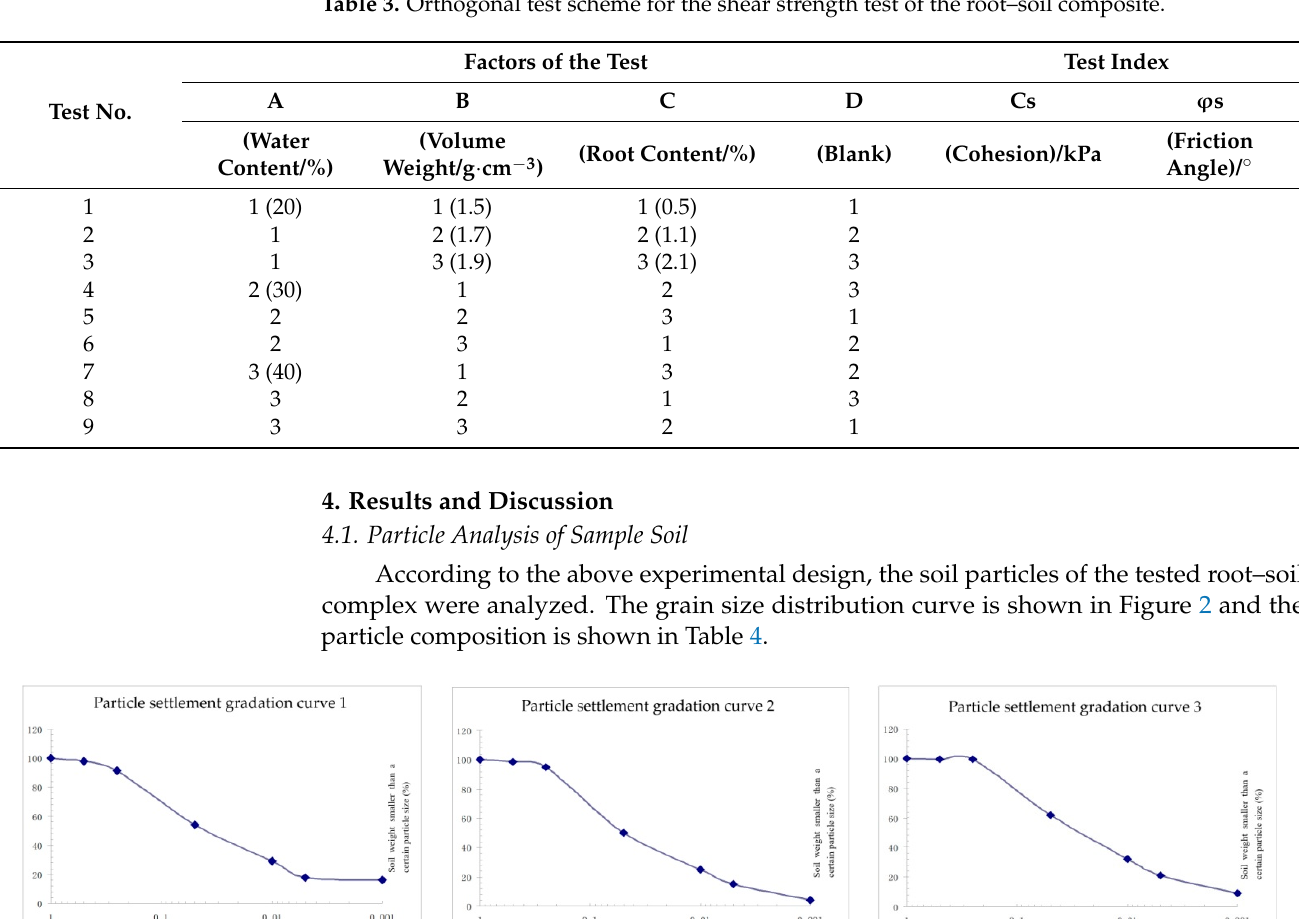
Table 2. Level table of testing factors for the mechanical characteristics of rice straw.